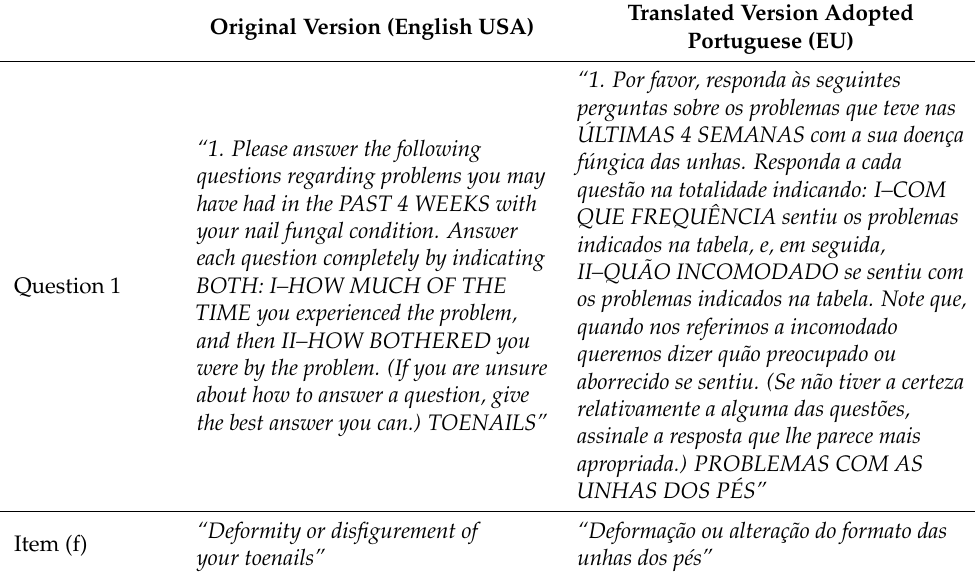
Table 5. Expert committee review of the original and translated version adopted of the OnyCOE-t TM